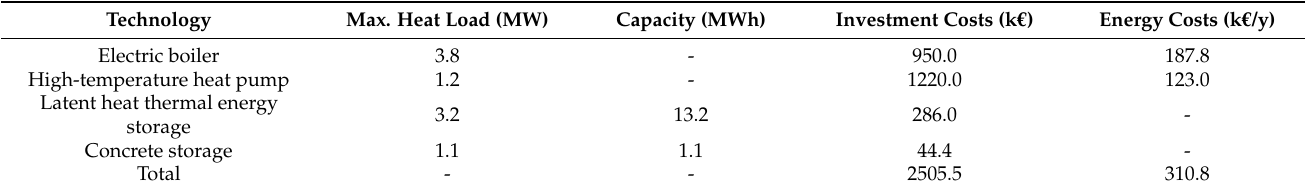
Figure 16. Cutout of the thermal storage and steam generator loads, steam demand and electricity price profiles for Case 2.